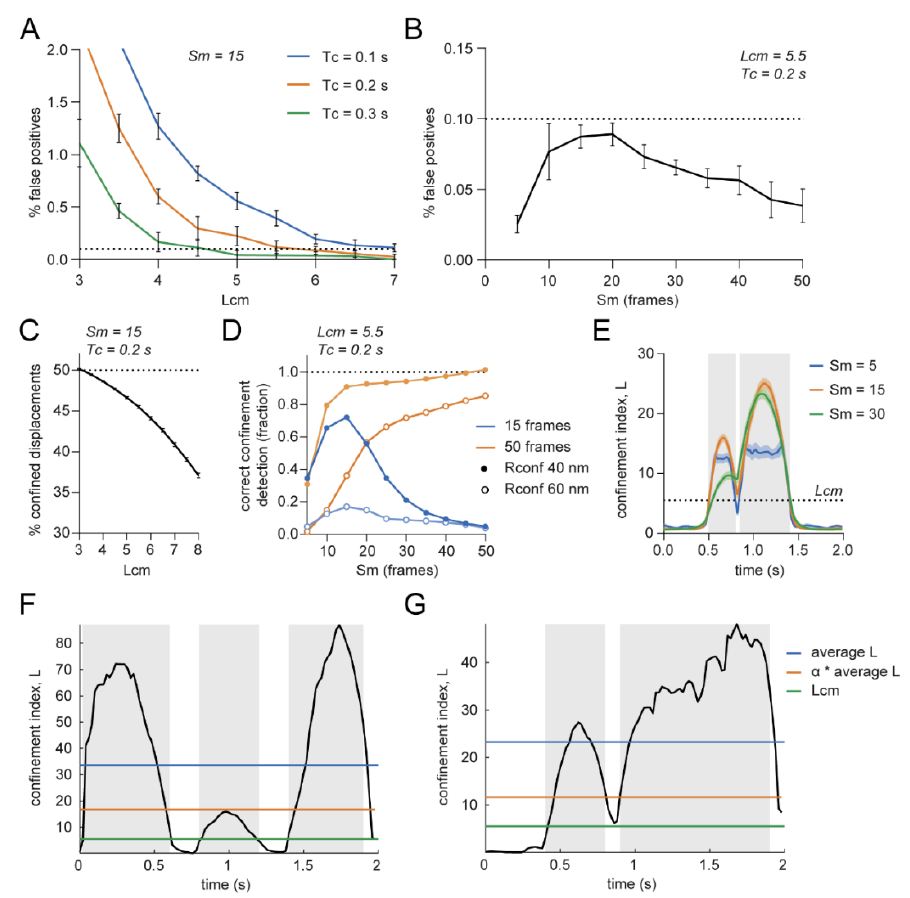
Figure 2. Influence of user-defined parameters on the confinement analysis. ( A ) Effect of minimal critical L ( Lcm ) and critical time ( Tc ) on percentage of false positives in simulated random walks. Dotted line indicates 0.1% false positives. Sm is 15. Five independent simulations of 100 trajectories. Data are represented as means ± SEM. ( B ) Effect of Sm on percentage of false positives in simulated random walks. Dotted line indicates 0.1% false positives. Lcm is 5.5 and Tc is 0.2 s. Five independent simulations of 1000 trajectories. Data are represented as means ± SEM. ( C ) Effect of Lcm on the percentage of detected confined displacements in trajectories simulated to be confined for 50 of the 100 frames. Sm = 15, Tc = 0.2 s, Rconf = 0.04 µ m. Five independent simulations of 1000 trajectories. Data are represented as means ± SD. ( D ) Effect of Sm on correct confinement detection in trajectories simulated to be confined 15 or 50 of the 100 frames. Lcm = 5.5 and Tc = 0.2 s. One hundred simulated trajectories per condition. ( E ) Effect of Sm on the ability to discriminate between multiple confinement zones shortly after each other. Lcm = 5.5 and Rconf = 0.03 µ m, 100 trajectories. Simulated confined periods are indicated with the gray boxes. Data are represented as means ± SEM. ( F ) Negative effect of ‘ α * average L ’ as Lc . Single simulated trajectory with three confinement zones. The middle confinement zone does not reach the threshold. Rconf = 0.015 µ m and 0.03 µ m and α = 0.5. Simulated confined periods are indicated with the gray boxes. ( G ) Positive effect of ‘ α * average L ’ as Lc . Single simulated trajectory with two confinement zones. With Lcm as threshold, both confinement zones would have been merged into one. Rconf = 0.03 µ m and α = 0.5. Simulated confined periods are indicated with the gray